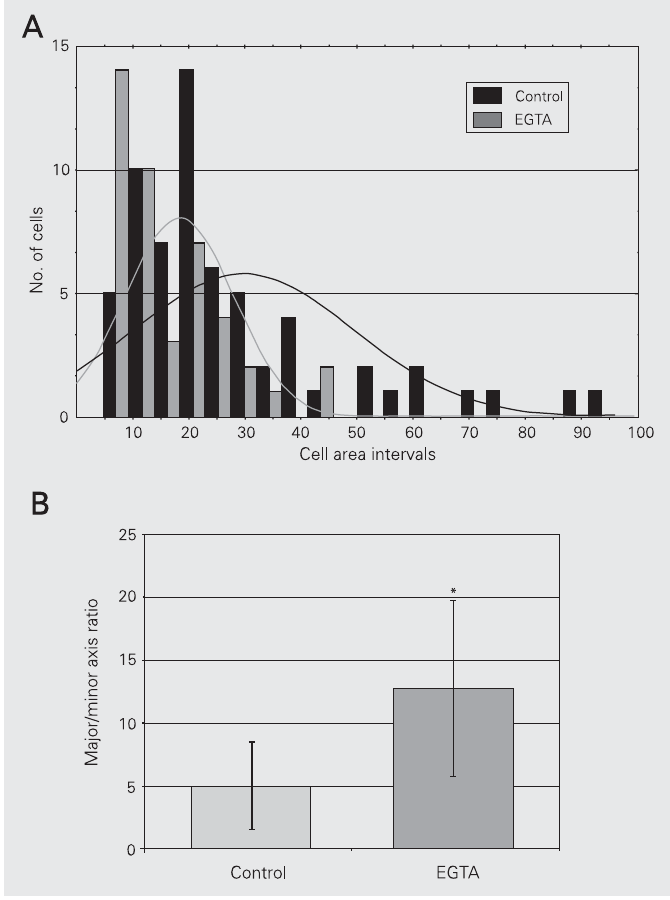
Figure 2. Histogram and best-fit plot of control and EGTA-treated cell area (A), and major/minor axis ratio of control and EGTA-treated cells (B). Axis ratio data from control and EGTA-treated groups were compared statistically (*P < 0.0001, t -test for independent samples). Both histograms were obtained from data described in the Results